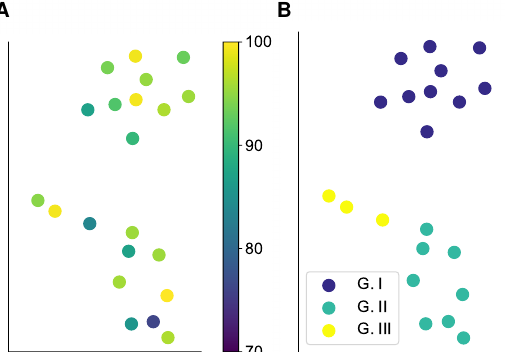
Figure 12. ( A ) Two-dimensional representation of the relevance vectors for each subject in the WM database obtained after applying t-SNE on (cid:36) n . ( B ) Groups identified by k-means. For the TE θ κα -based classifier the subjects grouped in G. I, have an average accuracy of 0.94 ± 0.04, while those in G. II and G.III have average accuracies of 0.92 ± 0.08 and 0.93 ± 0.08, respectively.